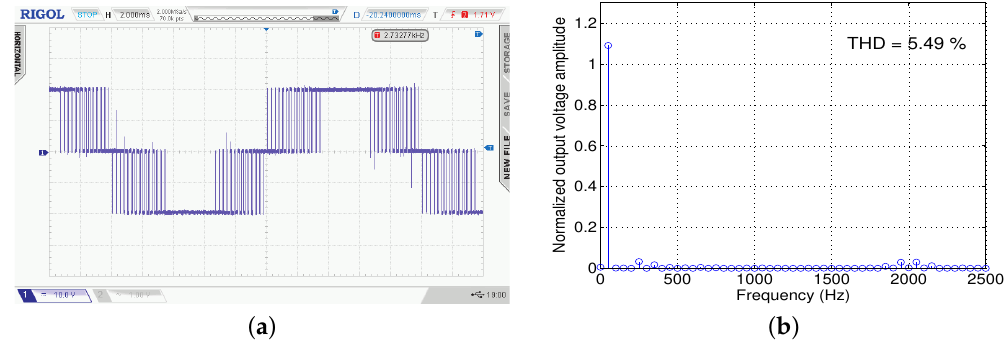
Figure 14. ( a ) Inverter output voltage with improved SPWM at m I = 1.1 and ( b ) Its frequency spectrum.